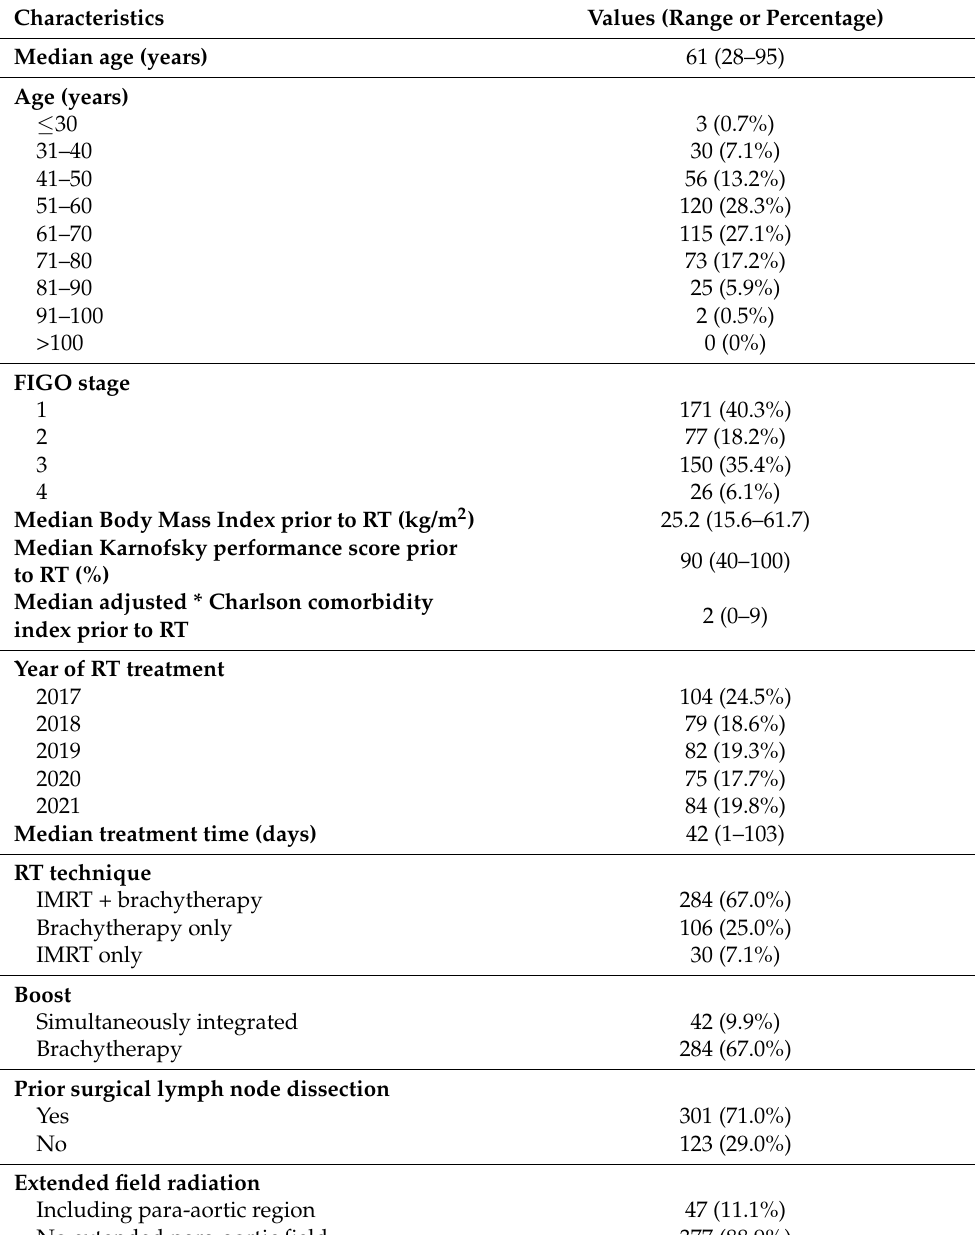
Table 1. Patient and treatment